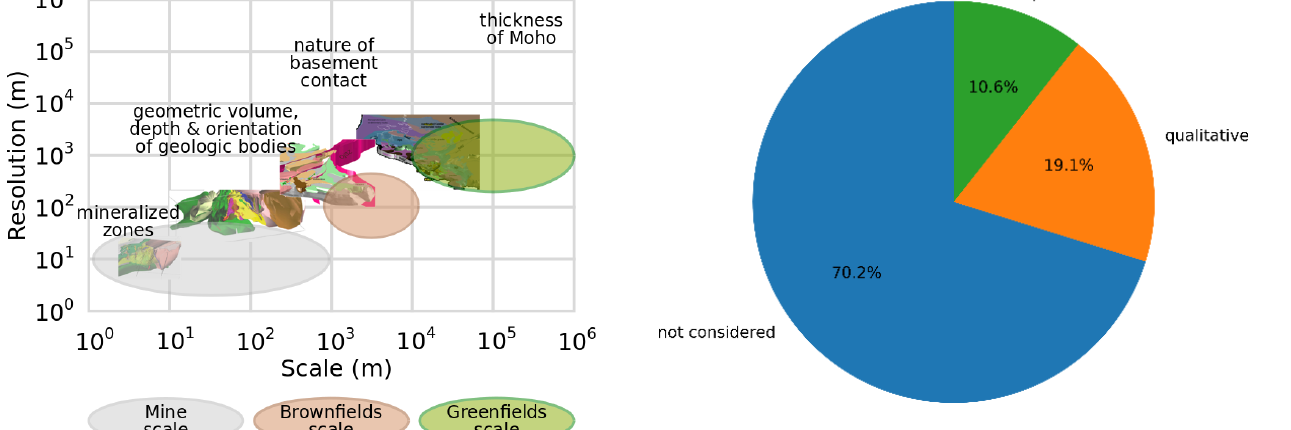
Figure 4. Consideration of input data uncertainty in